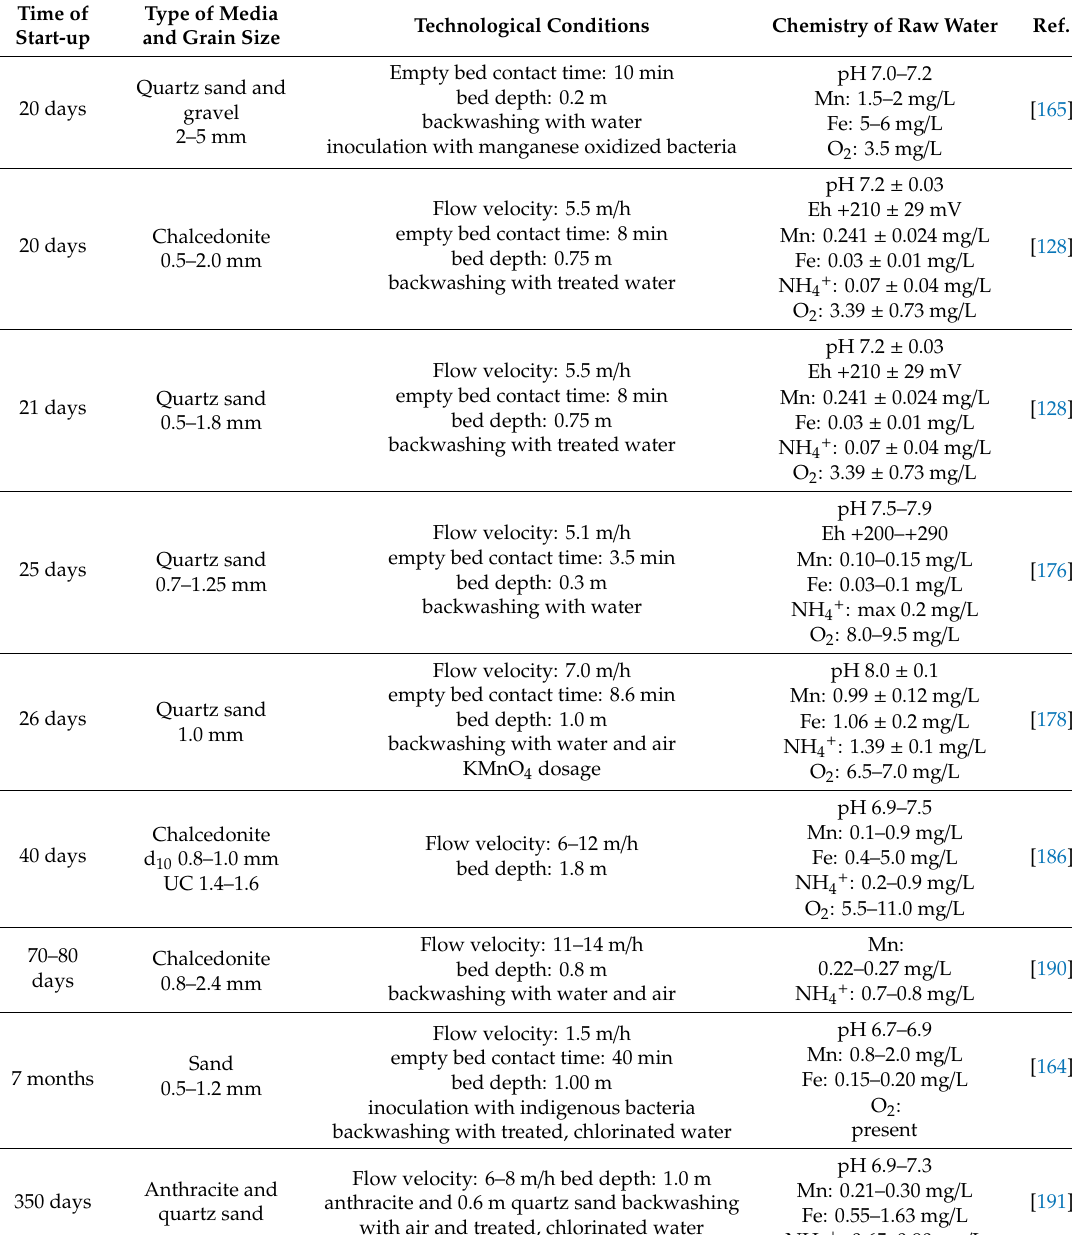
Table 5. Conditions of the start-up during naturally coating of the filter media. Adapted from [128]. Time of